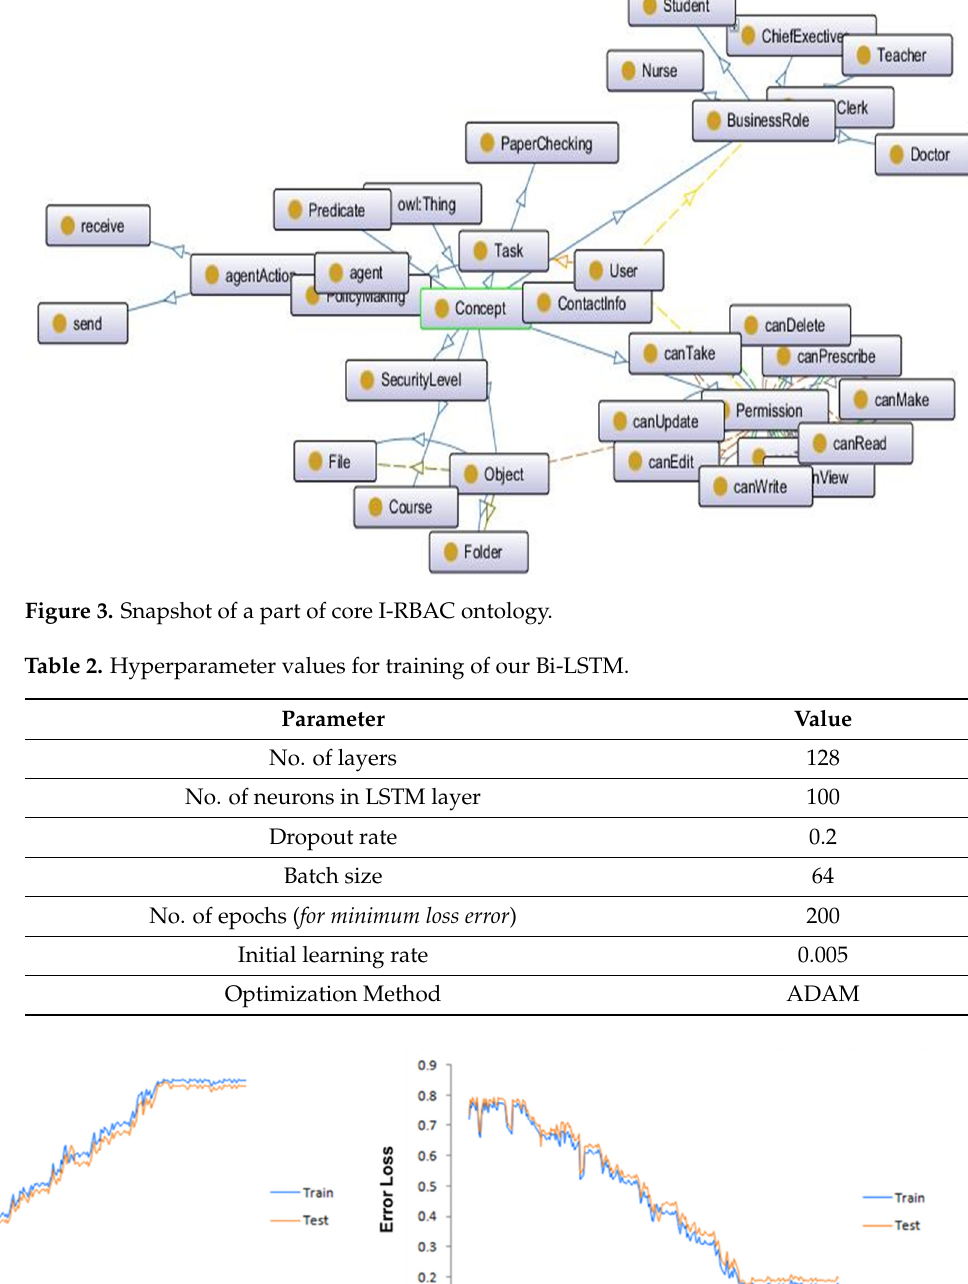
Table 2. Hyperparameter values for training of our Bi-LSTM.